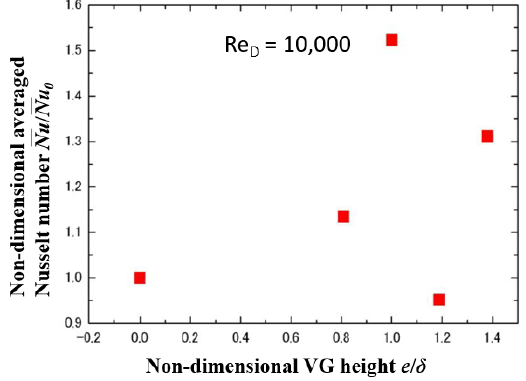
Figure 11. Effect of VG height on the local Nu distribution along boundary line in Figure 9 (fixed VG location: r / D = 2.5).